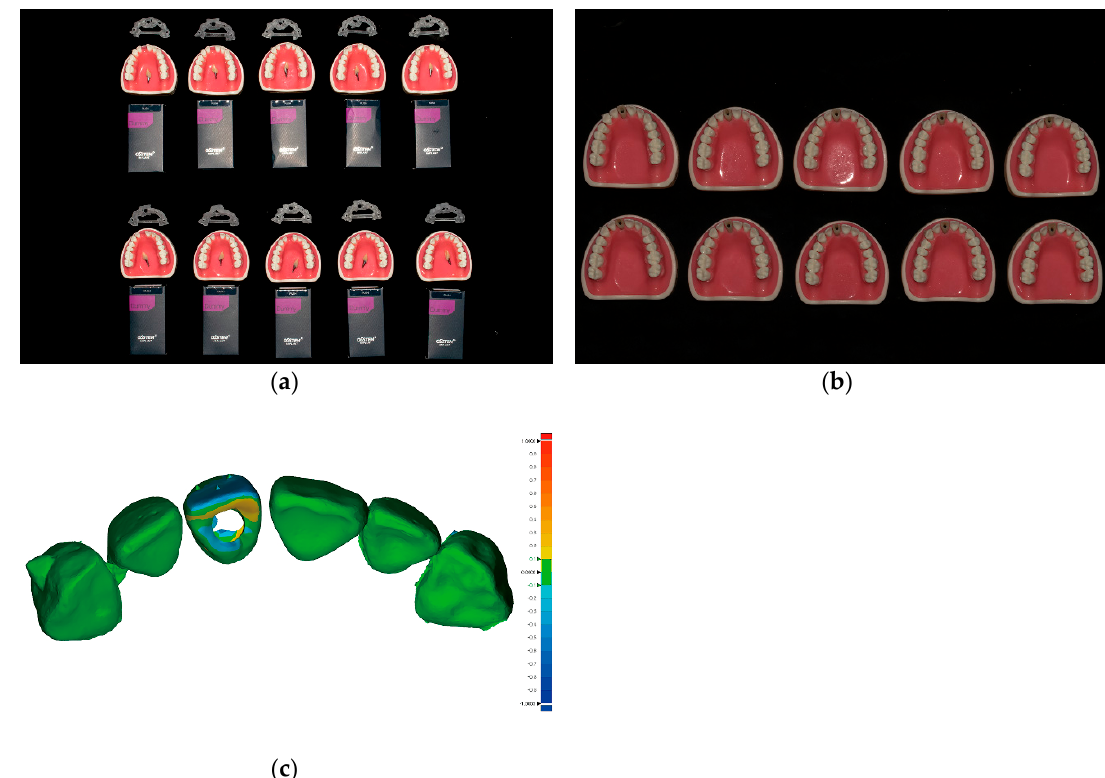
Figure 3. Comparison of the post-operative immediate provisional restoration position with the predesigned restoration position; ( a ) Ten sets of preparations prior to implant placement arranged in two rows (from top to bottom within each row) as follows: implant surgical guides, typodonts and customized prefabricated screw-type immediate provisional restorations placed above the typodonts, and implant fixtures; ( b ) Ten maxillary typodonts after the placement of implants and screw-type immediate provisional restorations; ( c ) An example image showing the difference between the pre-operative data and the post-operative scan data using metrology software (Geomagic Control X version 2018.0.1, 3D Systems, Cary, NC, USA). The critical value was set at ±1000 µm, and the tolerance value was set at ± 100 µm. Table 1. The angular deviation and root mean square (RMS) value between the pre-operative data and the post-operative scan data.